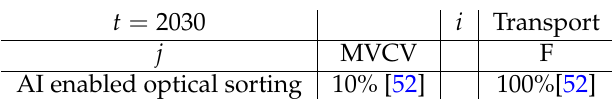
Table 14. Smart Waste management solutions